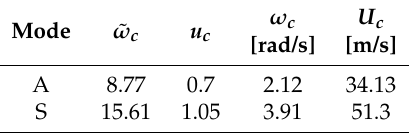
Table 1. Critical frequency and wind velocity in the antisymmetric and symmetric critical